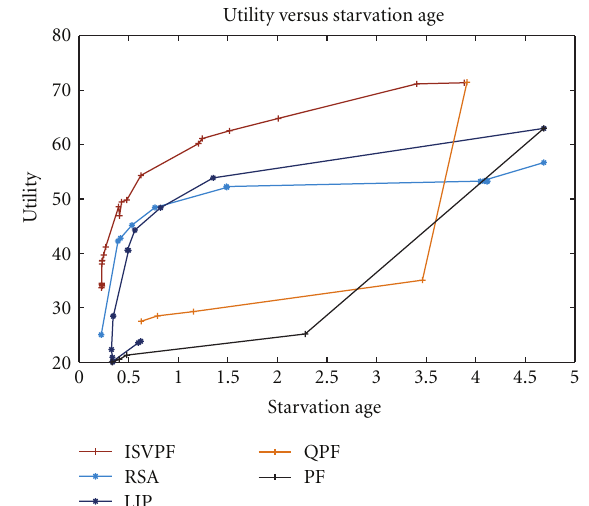
Figure 10: Utility ( (cid:26) Ψ ) versus Starvation Age ( (cid:26) χ ) when queue length =